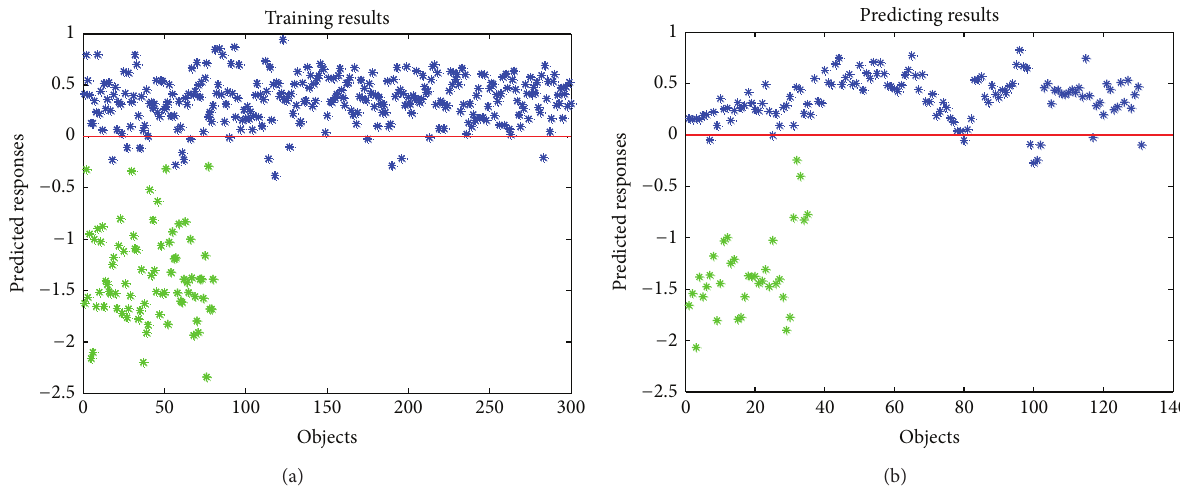
Figure 4: Training (a) and predicting (b) results of PLSDA model based on NIR spectra with SNV preprocessed. Blue asterisks represent the ATT objects; green asterisks represent the NATT objects.